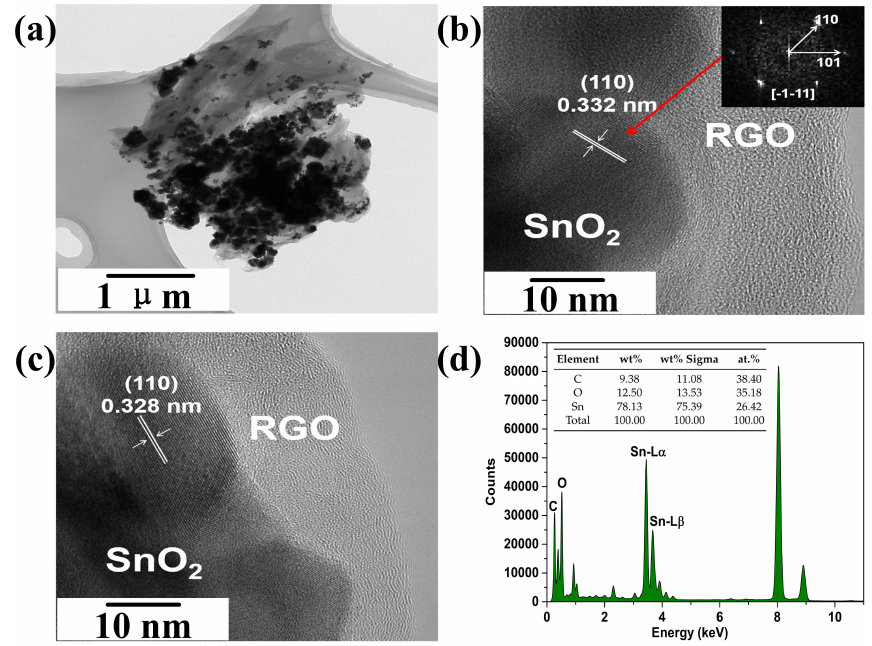
Figure 3. ( a ) TEM image, ( b , c ) HRTEM images and ( d ) EDX spectra of 5.1%RGO/SnO 2 nanocomposites. Inset in ( b ) presents the corresponding processed reduced FFT pattern of the HRTEM